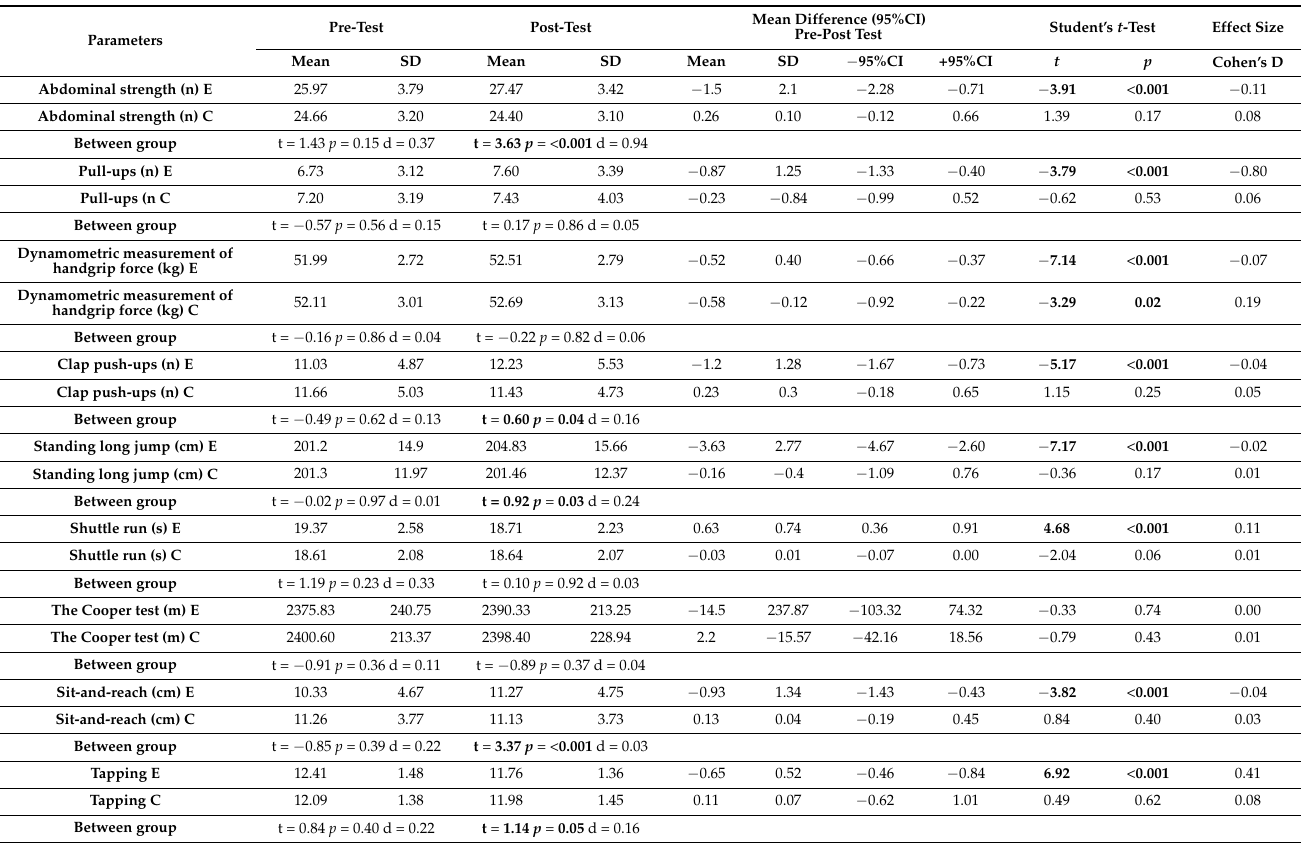
Table 3. General physical fitness of the participants before and after the experiment.